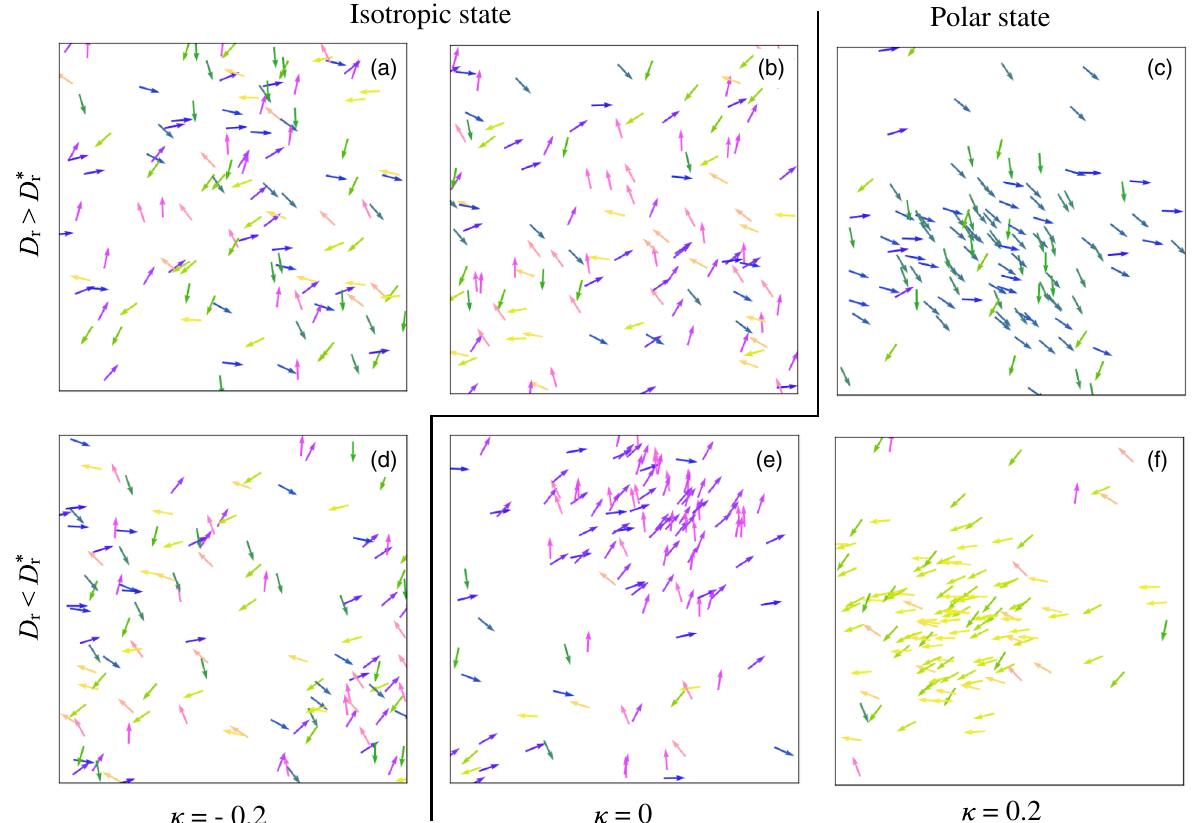
FIG. 7. Configurations obtained from a direct sampling of the biased ensemble for aligning self-propelled particles. The color code refers to the orientation of particles. In the unbiased dynamics ( κ ¼ 0 ), we observe isotropic and polar states, respectively, at large noise 8 , and we take the noise values D 7 ; 9 g for, respectively, the > D (cid:4) < D (cid:4) ( D ) and small noise ( D ). Here, the critical noise is D (cid:4) r r r ¼ r r r ¼ f polar and isotropic regimes. The dynamical bias leads to renormalizing interactions in a controlled manner, which effectively changes → D (cid:4) 1 þ κ Þ at leading order. As a result, one can stabilize either isotropic or polar states, respectively, for the transition threshold as D (cid:4) r r ð κ < 0 and κ > 0 , thus illustrating the ability to trigger or inhibit collective effects in nonequilibrium systems. Simulation details are in Appendix A and movies in Ref.